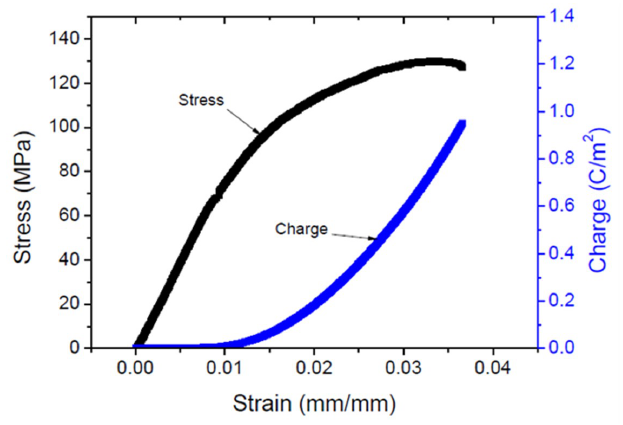
Figure 5. Stress–strain and charge curves of cellulose ZnO hybrid nanocomposite (CEZOHN) [38]. Table 3. Comparison of Young’s modulus and piezoelectric charge constant of cellulose and cellulose ZnO hybrid nanocomposite (CEZOHN) [38,39].